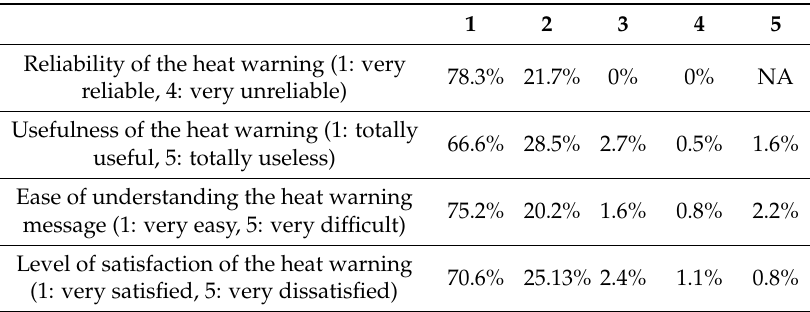
Table 2. The quality of heat episode warning